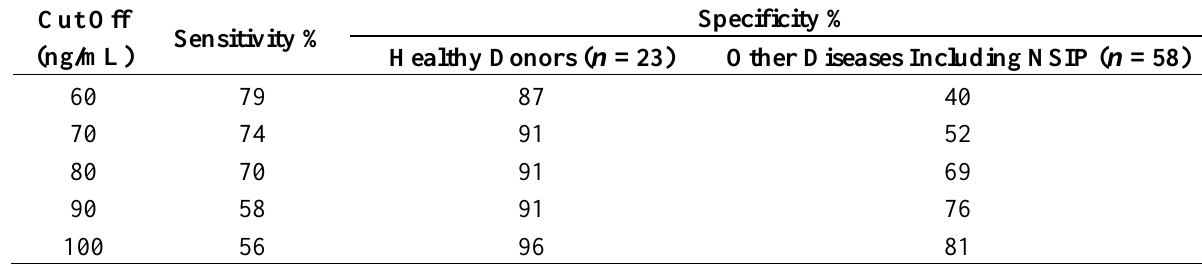
Table 2. Sensitivity and specificity values of free circulating DNA in discriminating between NSCLC patients (43) and healthy donors or individuals with other lung diseases.